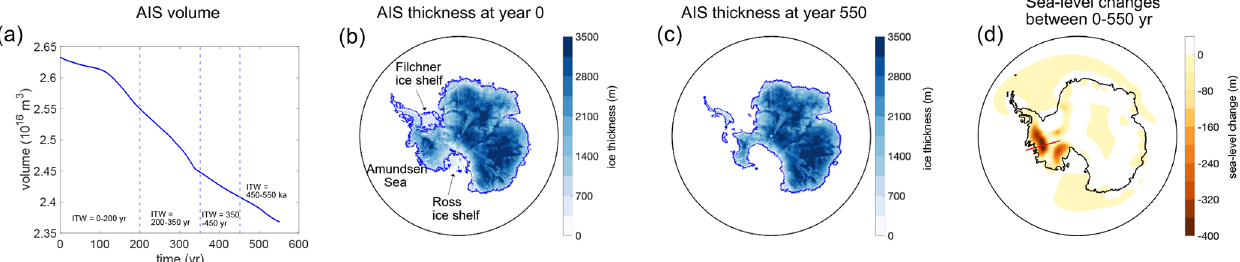
Figure 6. Changes in Antarctic Ice Sheet volume and thickness over 550 years from DeConto et al. (2021) and associated total sea-level changes predicted in a stand-alone (uncoupled) sea-level simulation. (a) AIS volume variations through 550 years. Vertical dashed lines mark the internal time windows. (b, c) Snapshots of ice thickness (blue) and grounding lines (blue contour lines) at (b) 0 years and (c) 550 years. (d) Total sea-level changes between 0–550 years associated with the ice loading changes between 0–550 years. Note that the regions (in yellow and red) that show negative sea-level changes are where sea level has fallen because of solid Earth uplift and the drawdown of sea surface height associated with ice mass loss. The red line represents a cross section perpendicular to a grounding line in the West Antarctic region where the most intense sea-level change (fall) happens (see also Fig.